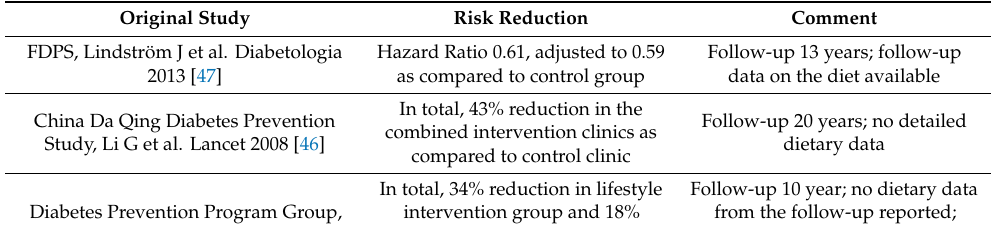
Table 4. Long-term post-intervention preventative e ff ect on the incidence of type 2 diabetes in the former intervention groups compared to control groups in three randomized controlled lifestyle intervention studies.